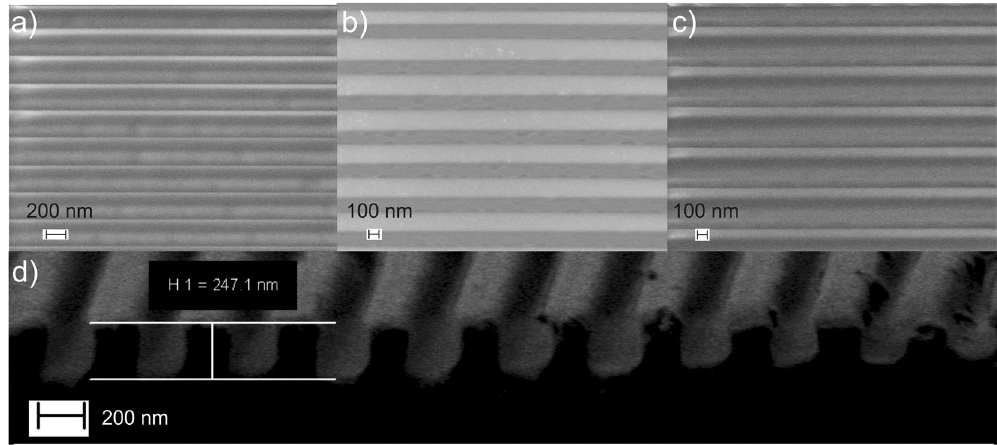
Fig. 3 SEM images of gratings structures fabricated in CdA fi lms, with a SP, b MP, and c LP. d Cross section of an LP CdA Figure 5 shows the emission spectra of (a) PFO, (b) F8BT, and (c) P3HT:F8BT fi lms deposited on top of corrugated CdA substrates at excitation densities below and above the lasing thresholds, as well as the corresponding input – output curves of emission intensity vs. pump fl uence. The dotted lines represent the normalized emission spectra at pump fl uence just below the respective laser thresholds. The blue, green, and red solid lines, on the other hand, represent lasing